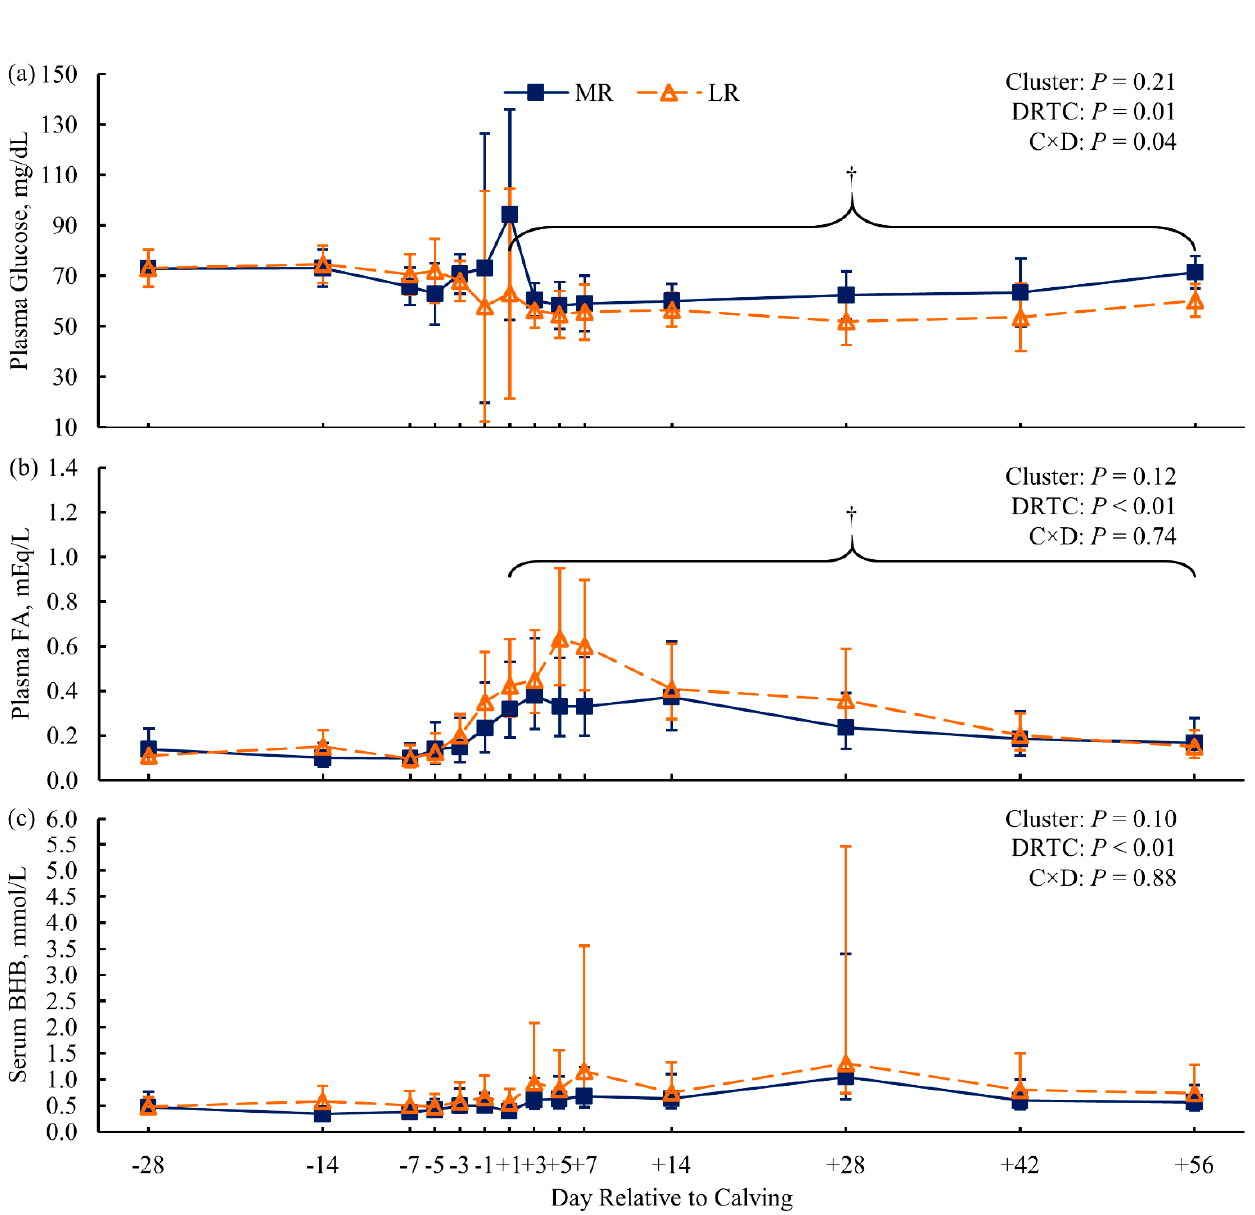
Figure 4. Blood fraction concentrations of glucose (panel a ), fatty acids (FA; panel b ), and β -hydroxybutyrate (BHB; panel c ) for dairy cows more resistant (MR) or less (LR) resistant to lipid-related metabolic disorders ( n = 3 cows per cluster). Data are presented as least squares means (points) and their 95% confidence intervals (error bars). Statistics for the fixed effects of cluster, day relative to calving (DRTC), and their interaction (C × D) are displayed in the top-right corner of each panel. Marginal evidence (†; p = 0.07, panel a ; p = 0.06, panel b ) for contrasts of cluster across postpartum samples (bracketed) are indicated within their respective panels.